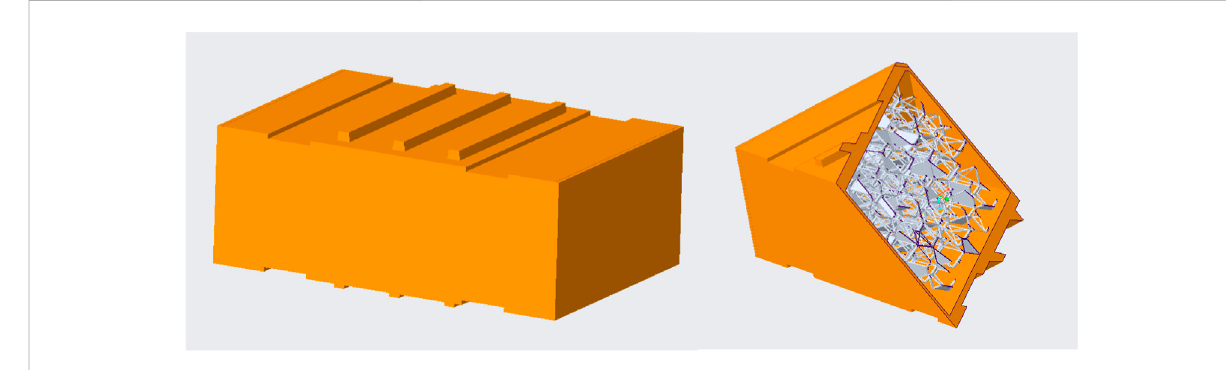
FIGURE 1 Diagram of the full geometry of the UAV fuel tank and its interior